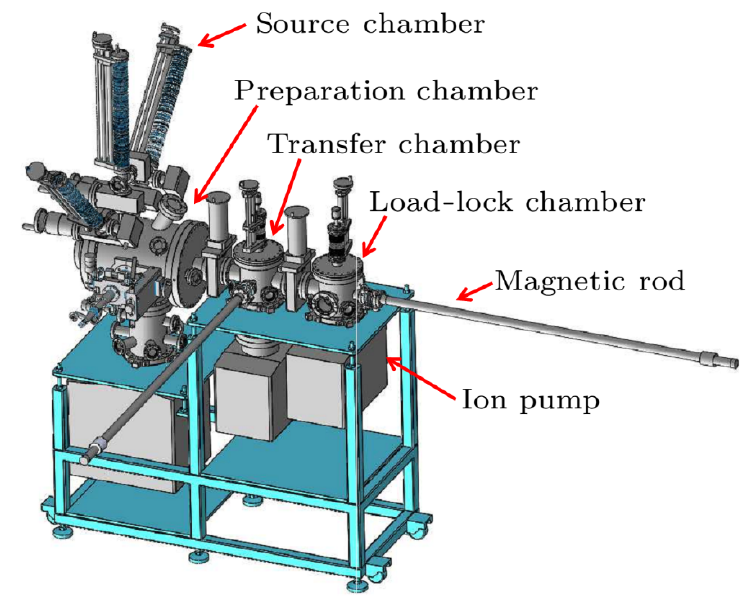
Figure 7. The bialkali photocathode deposition system at IHEP [59].